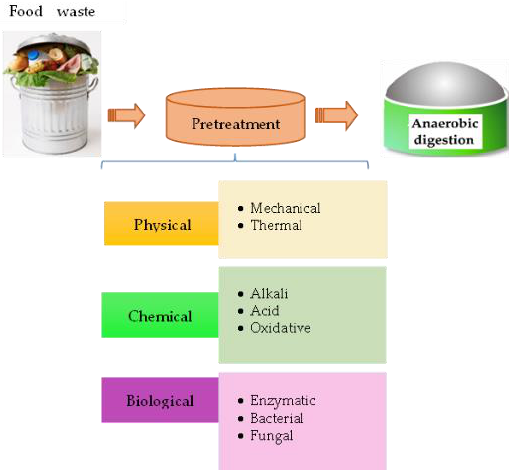
Figure 8. Food waste pretreatments (modified after [134,135]).